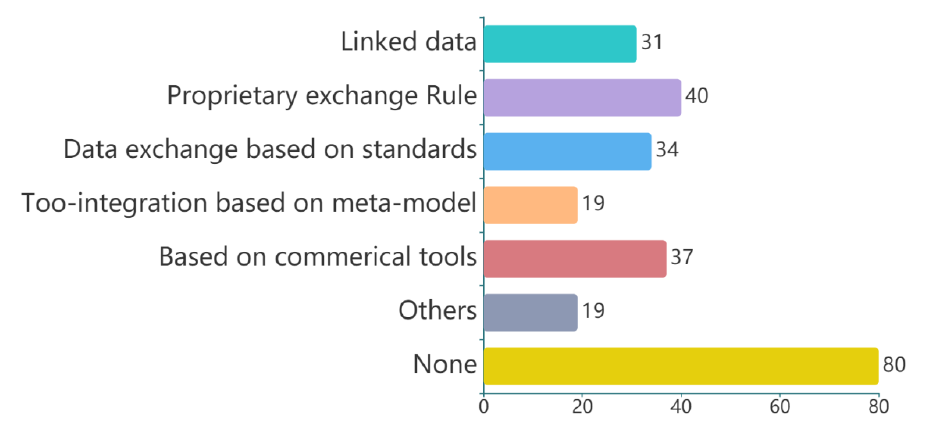
Figure 16. Survey on tool integration